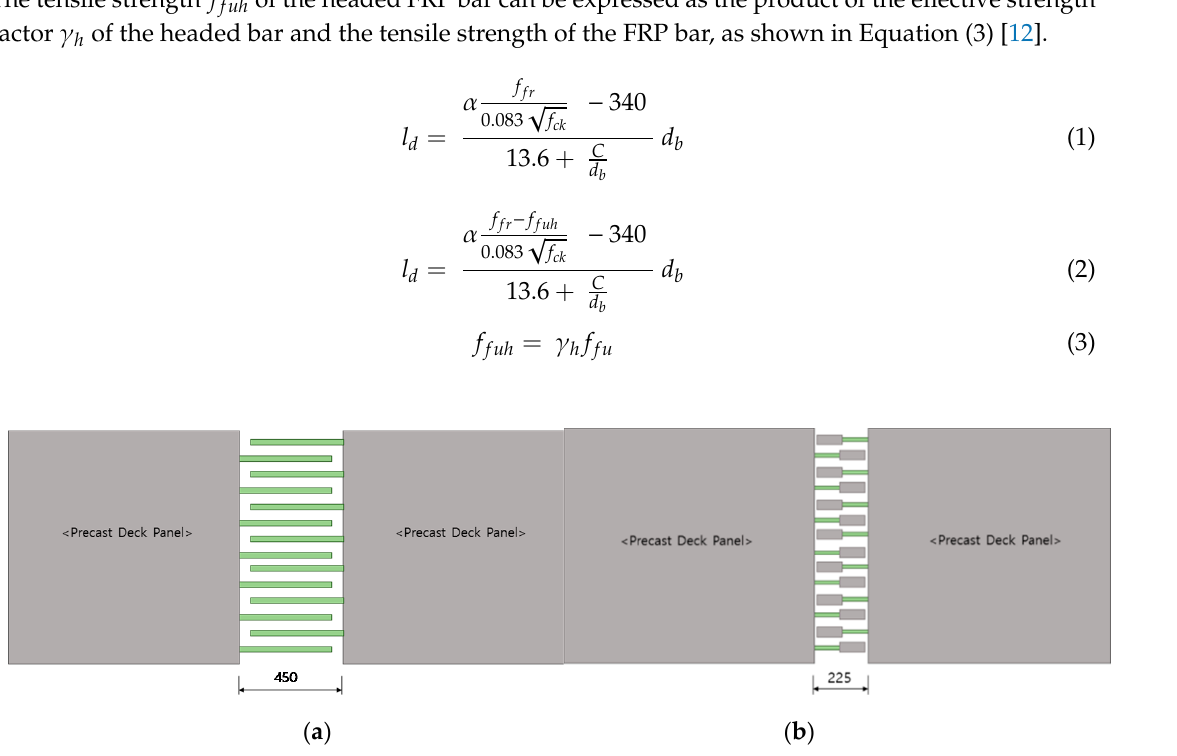
Figure 9. Schematic diagram of ( a ) the connection joint of the splice of GFRP rebars and ( b ) the connection joint of headed GFRP rebars. Table 4. Test variables for flexural test on the connected precast concrete deck.